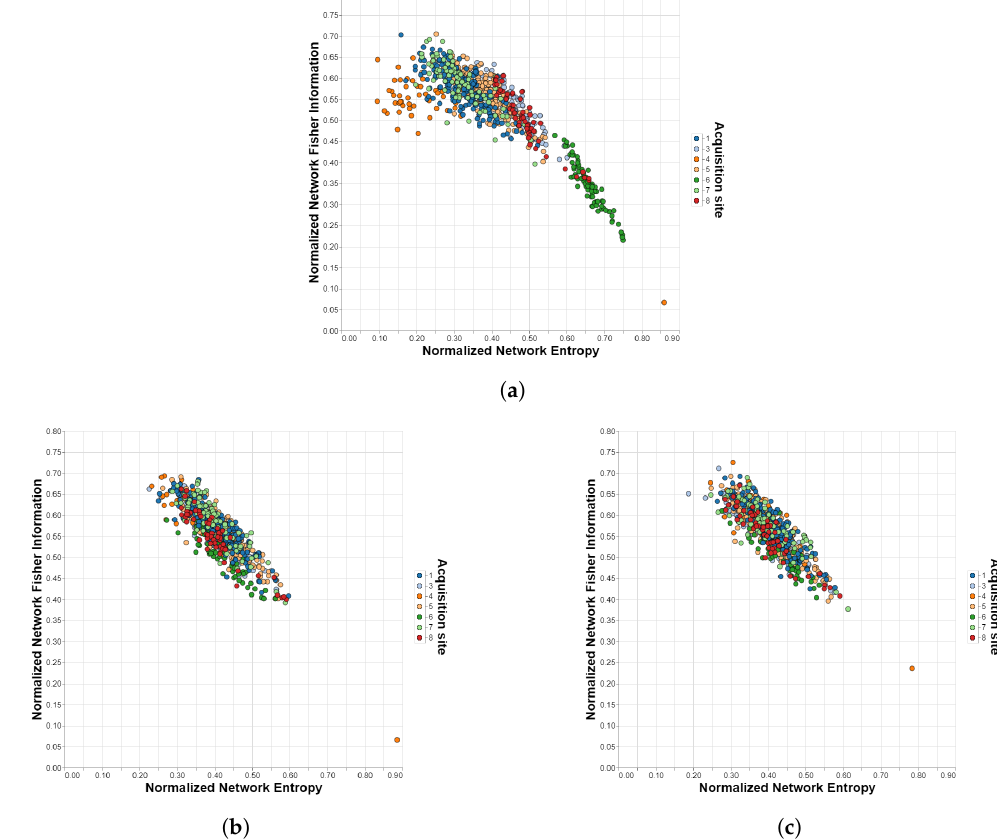
Figure 2. Shannon–Fisher planes for ADHD-200/Harvard-Oxford with different harmonization methods. Each point corresponds to a different subject in the dataset and each color to a different acquisition site. ( a ) Unharmonized. ( b ) ComBat. ( c ) CovBat. Table 1. Transformed p -values obtained with the Kruskal–Wallis test for the components of the Shannon–Fisher plane. Bold values represent p (cid:48) ≤ 1.301, which corresponds to p ≥ 0.05 and, therefore, evidence is not enough to reject the null